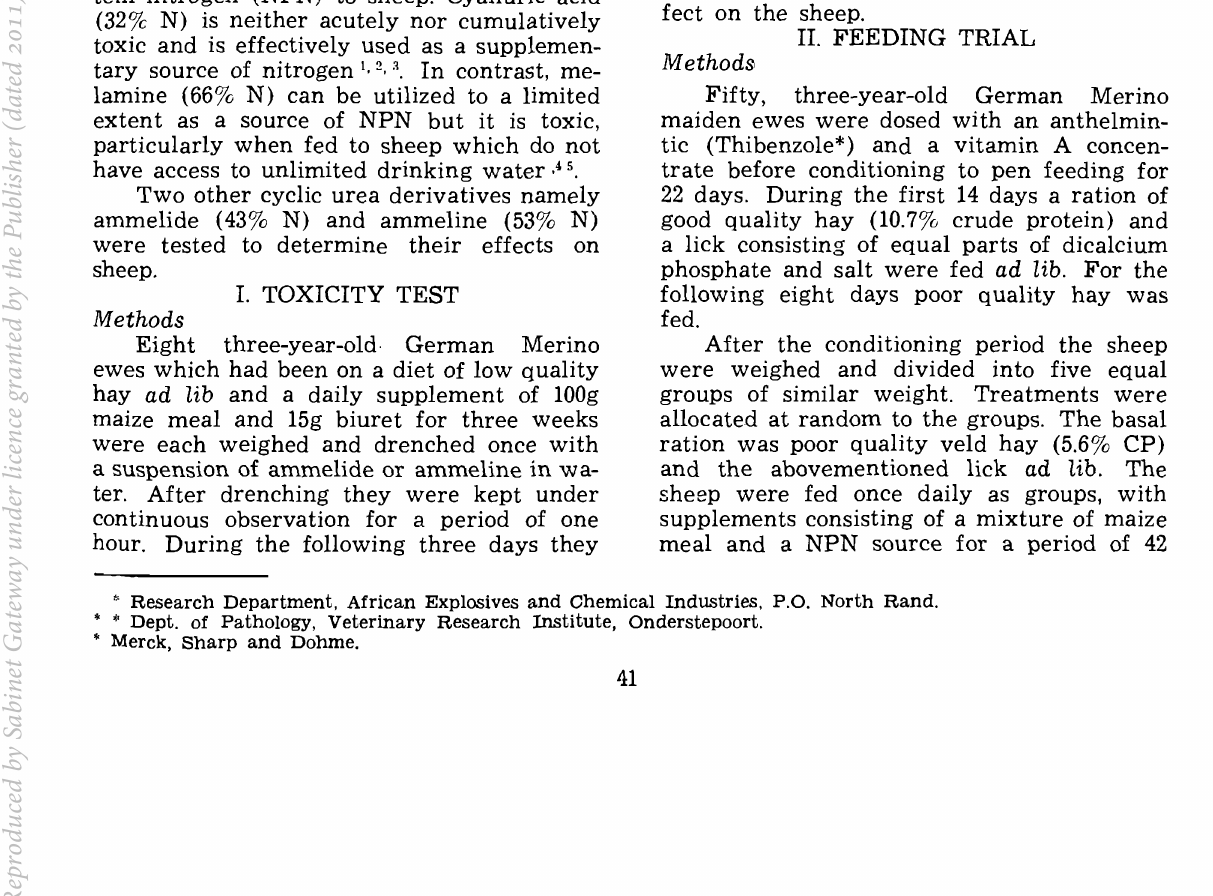
TABLE 1: DOSAGES AS A SINGLE DRENCH